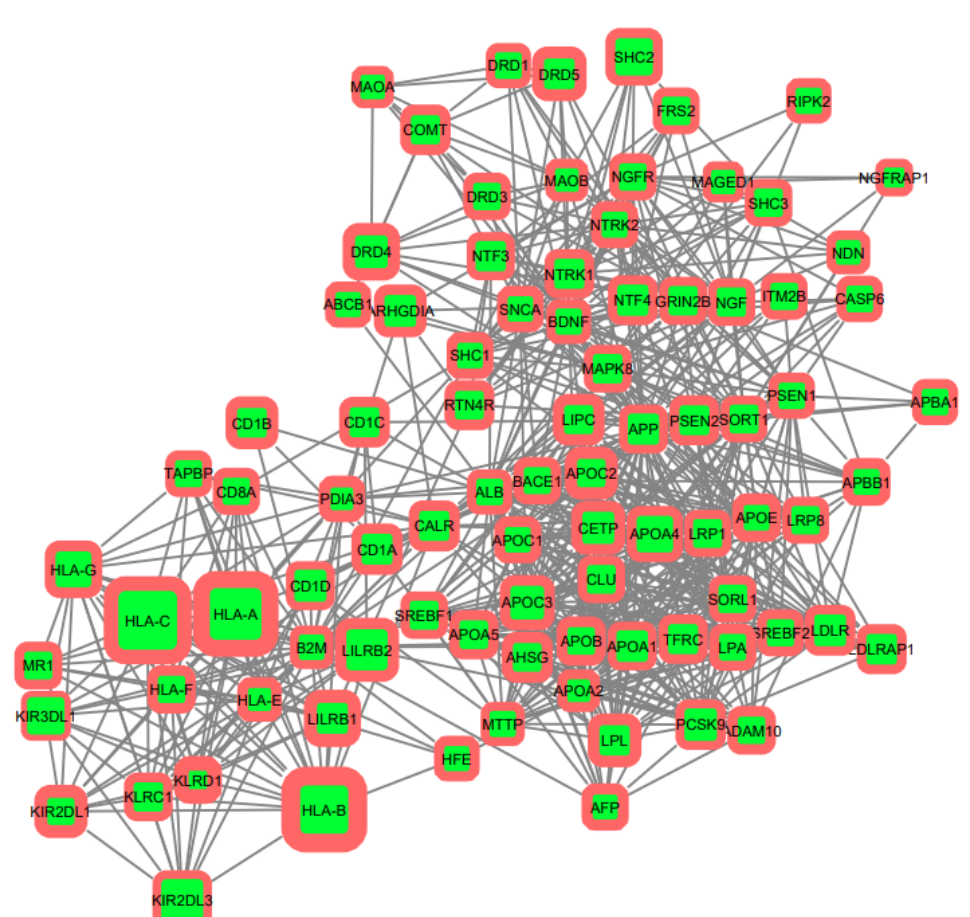
Figure 1. Protein–protein interactions network reconstructed on the initial gene set via String DB (visualized in Cytoscape). Size of node refers to SNP (single nucleotide polymorphism)-part in gene coding region, border thickness—SNP-part in promotor region.